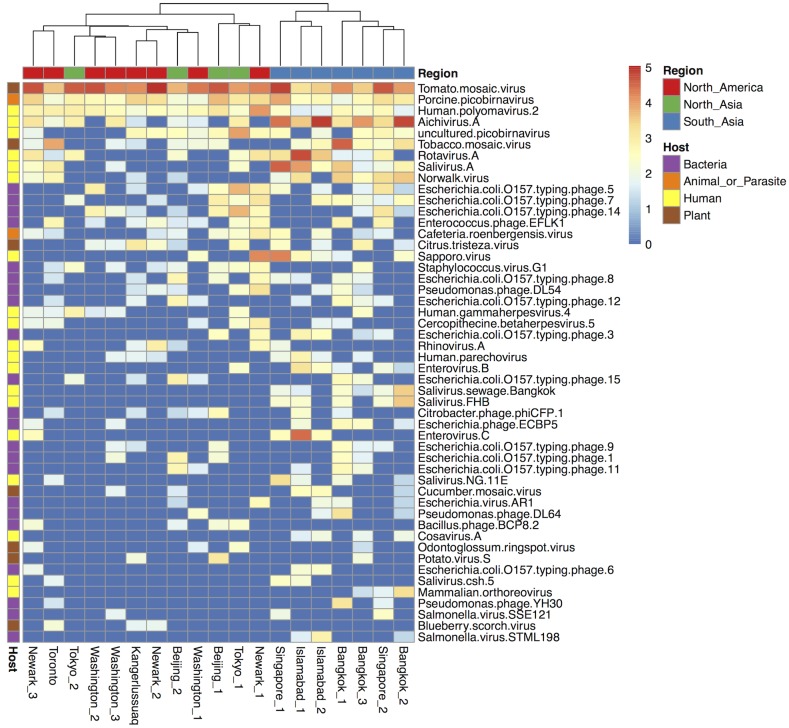
Heatmap of the top 50 most abundant viruses in the airplane toilet waste.Read number values were converted to Viral Reads Per Million (VRPM) and log 10 transformed. Hierarchical clustering was done on the airplane samples and colored by region. The putative viral host is marked in the left column. In some cases the host is debated, and these are discussed more in the Discussion and Strengths and Limitations sections.